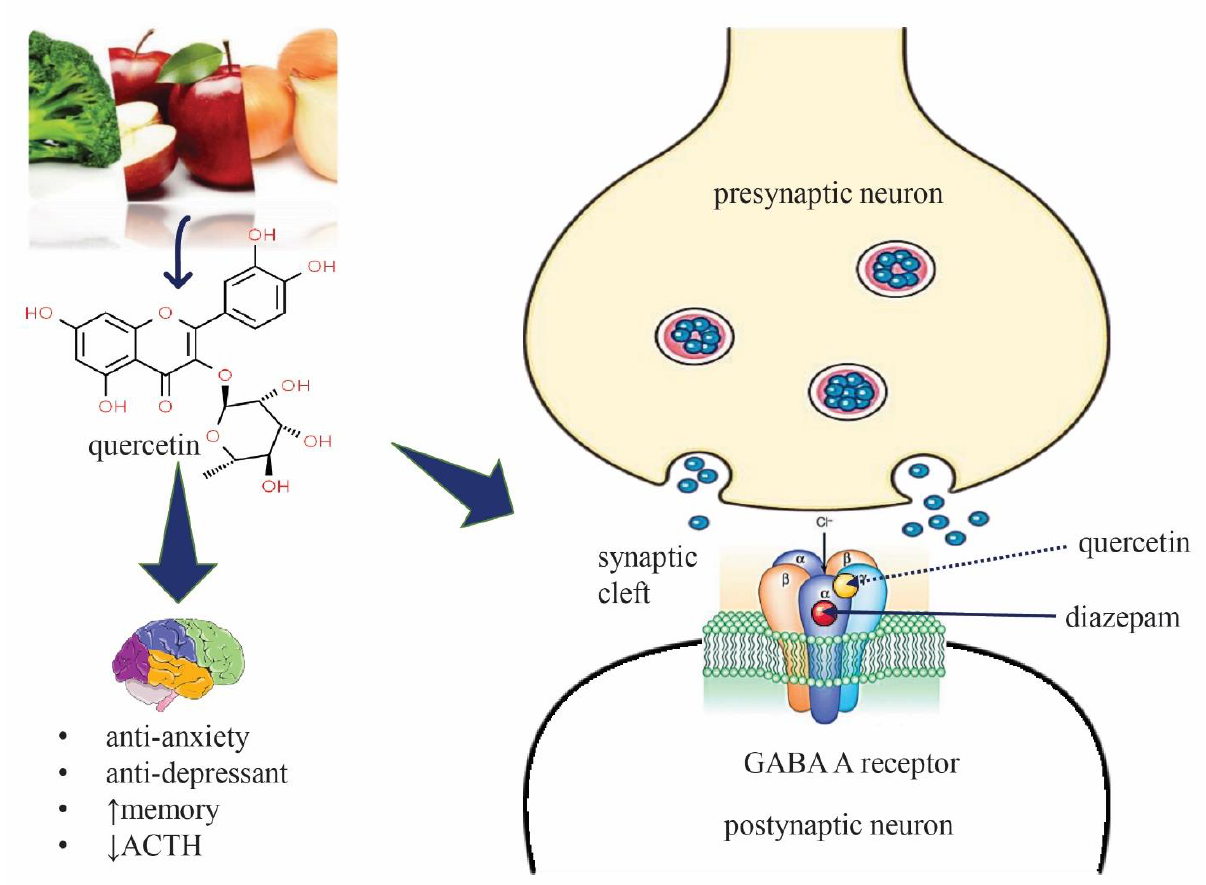
Figure 7. Anxiolytic-like effect and potential molecular mechanism of action of quercetin with GABA A receptor. Legend: ↑ increase; ↓ decrease; the arrow with a solid line shows that diazepam binds GABAA α2, whereas the arrow with a dotted line suggests that QUR’s anti-anxiety action might be linked to potential regulation of GABA A α2 subunit; ACTH, adrenocorticotropic hormone.